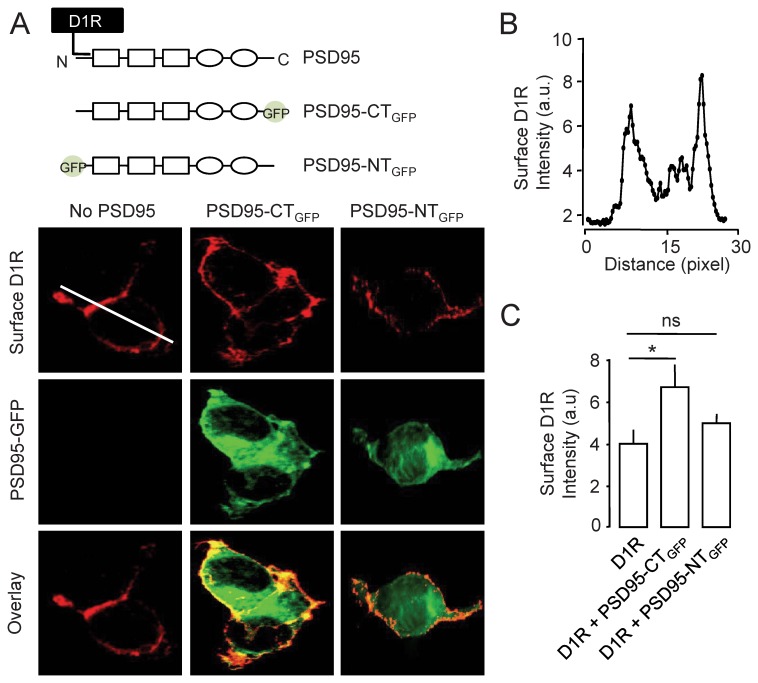
GFP insertion at the N-terminus of PSD-95 prevents the D1R-PSD95 interaction-induced D1R surface delivery.(A) Schematic representation of the interaction between PSD-95, characterized by its PDZ binding (squares), SH3 and GK domains (rounds), and D1R (upper panel). Note that the interaction occurs at the N-terminus domain of PSD95. Two variants of PSD95 were transfected in HEK cells: PSD95-CTGFP that contains a GFP at its C-terminus and PSD95-NTGFP that contain a GFP at its N-terminus (insertion at amino acid position 32). HEK cells were transfected with D1R-CFP and either PSD95-CTGFP or PSD95-NTGFP (do not bind to D1R). The surface content of D1R was measured by immuncytochemistry in the transfected cells (lower panel). (B) Line scan (white line in A) of the immunofluorescence of surface D1R from a HEK cell transfected with D1R alone. Note that D1R are enriched at the plasma membrane. (C) Quantification of the surface content of D1R in the various conditions. The co-expression of PSD95-CTGFP increases the surface content of D1R (P<0.05), whereas the co-expression of PSD95-NTGFP has no significant effect on the surface content of D1R (P>0.05).